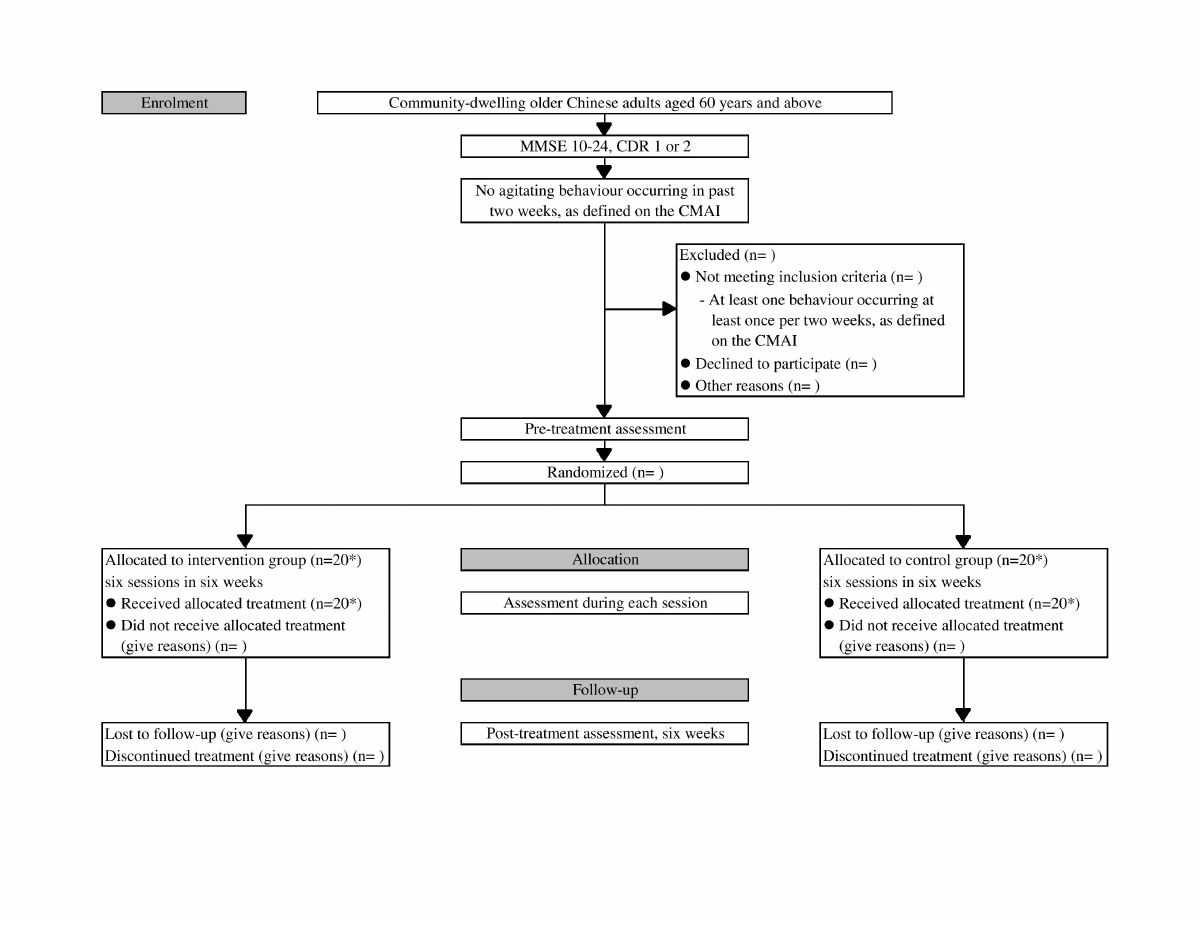
Figure 2. Flow chart of the study design. *Indicates the target number of subjects. CDR: Clinical Dementia Rating, CMAI: Cohen-Mansfield Agitation Inventory, and MMSE: Mini-Mental State